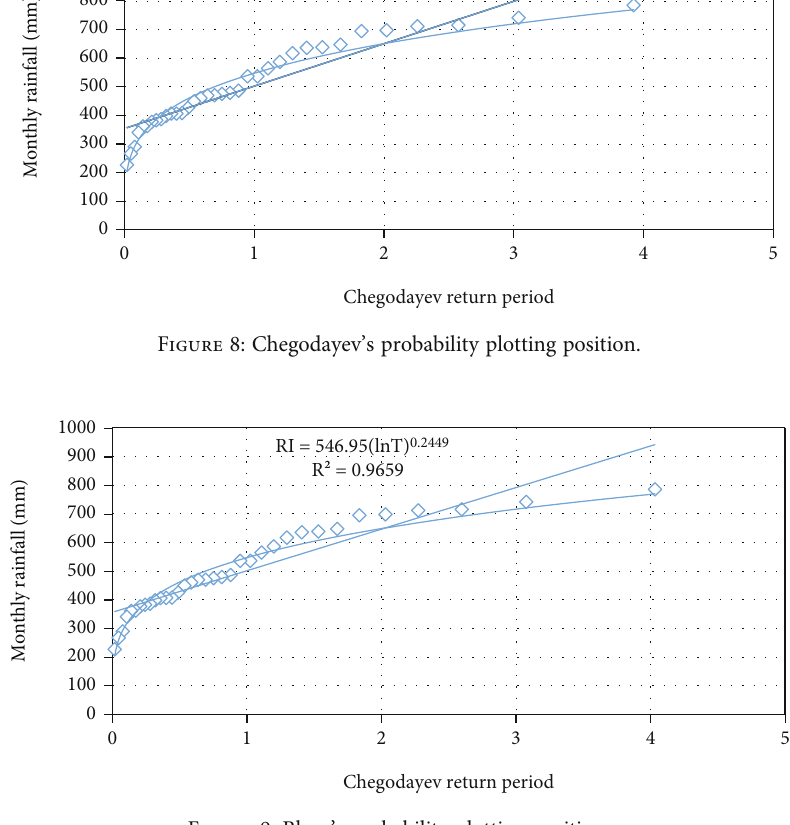
Figure 9: Blom ’ s probability plotting position.